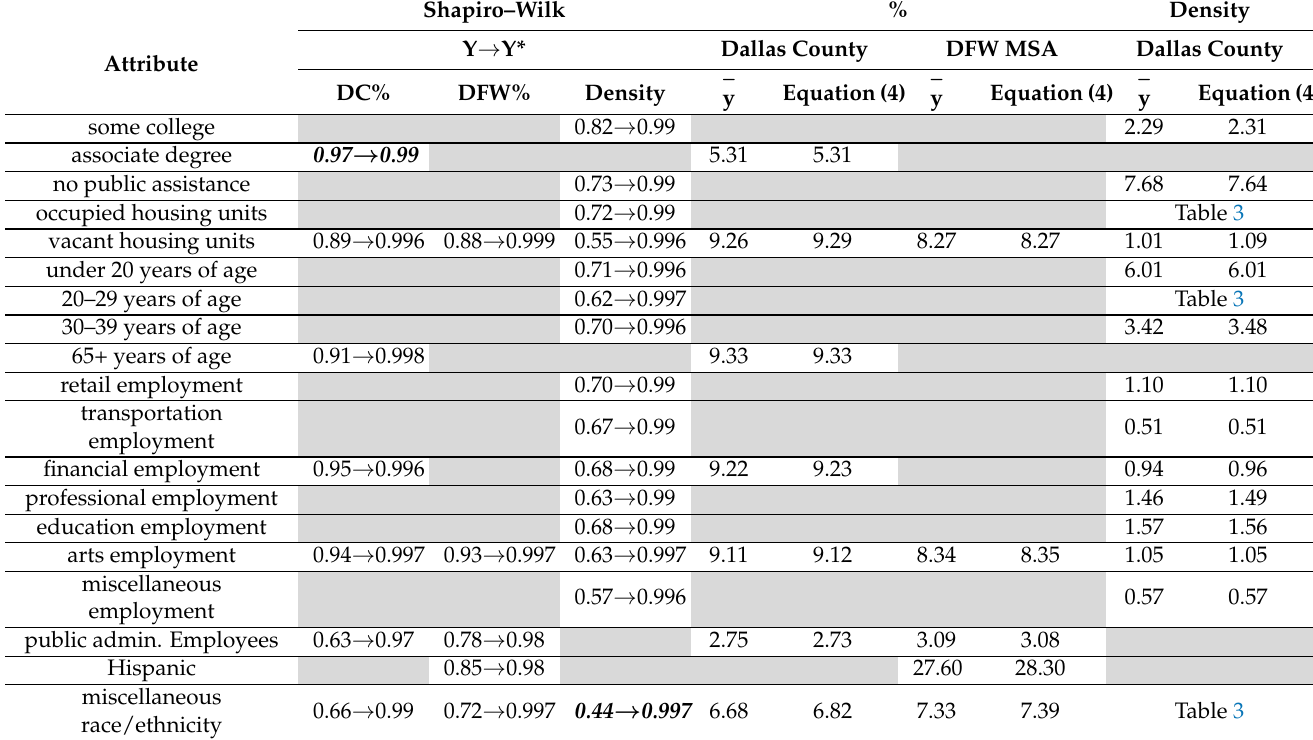
Table 5. Selected Box–Cox power transformed 2010% and density attribute variables experiencing individual Gaussian probability density function correspondence